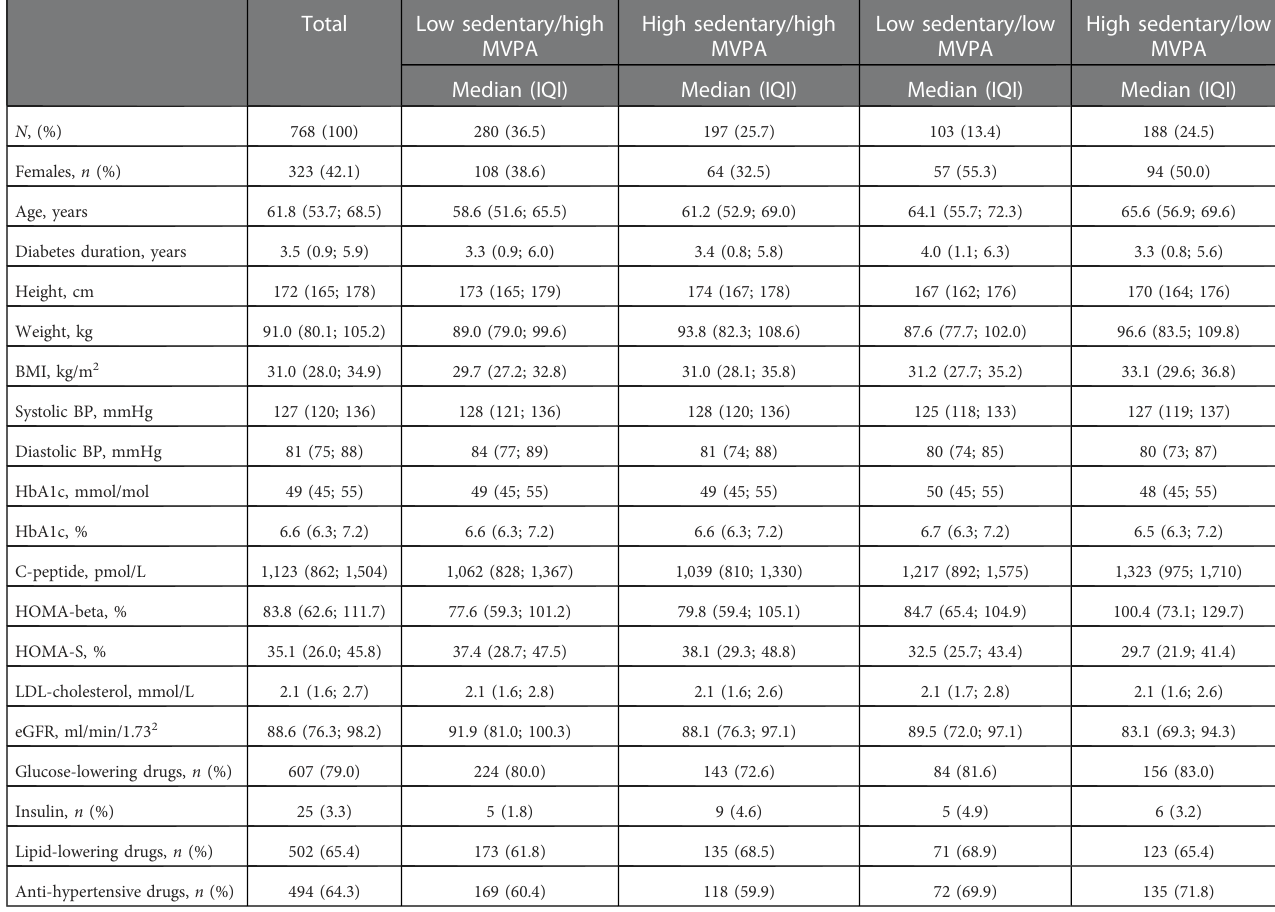
TABLE 1 Characteristics of study participants strati fi ed by physical activity pro fi